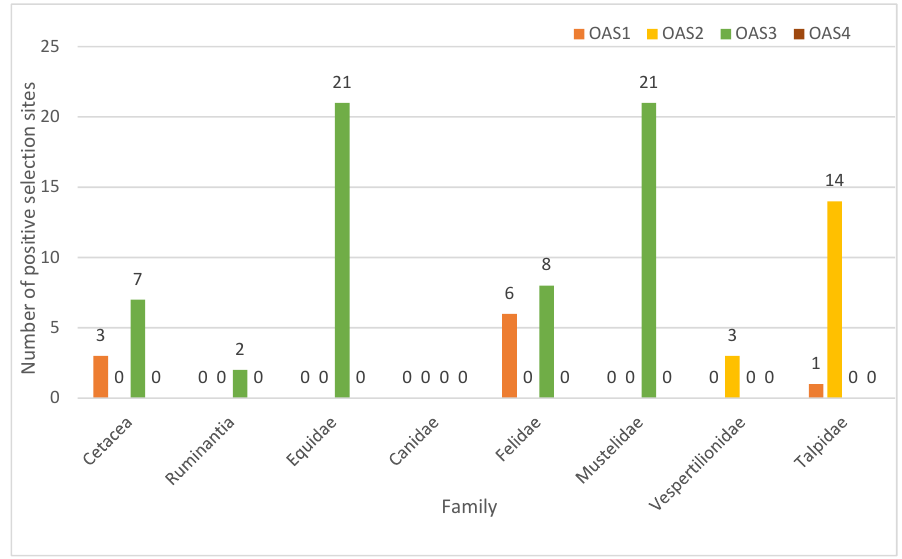
Figure 4. Positive selection for OAS gene branch locus models in Laurasiatherian mammals. Table 1. Analysis of positive selection sites for Laurasiatherian mammals